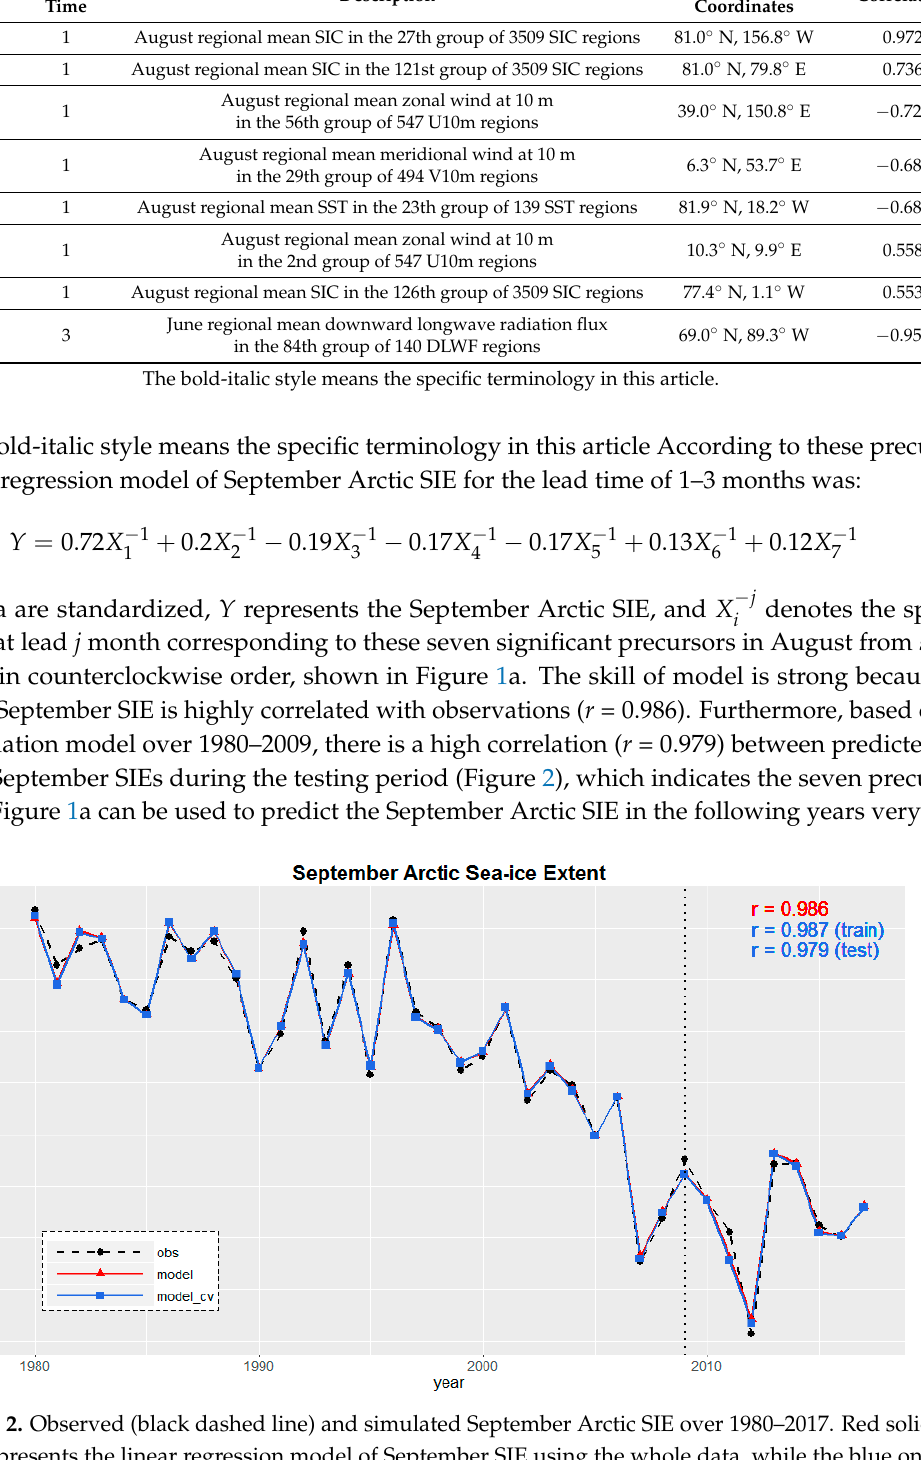
Table 2. Precursors associated with September Arctic SIE.